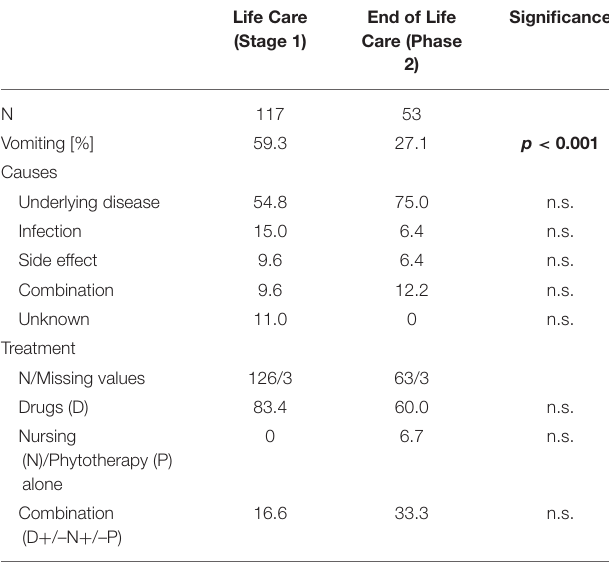
TABLE 3 | Causes/treatment of symptom